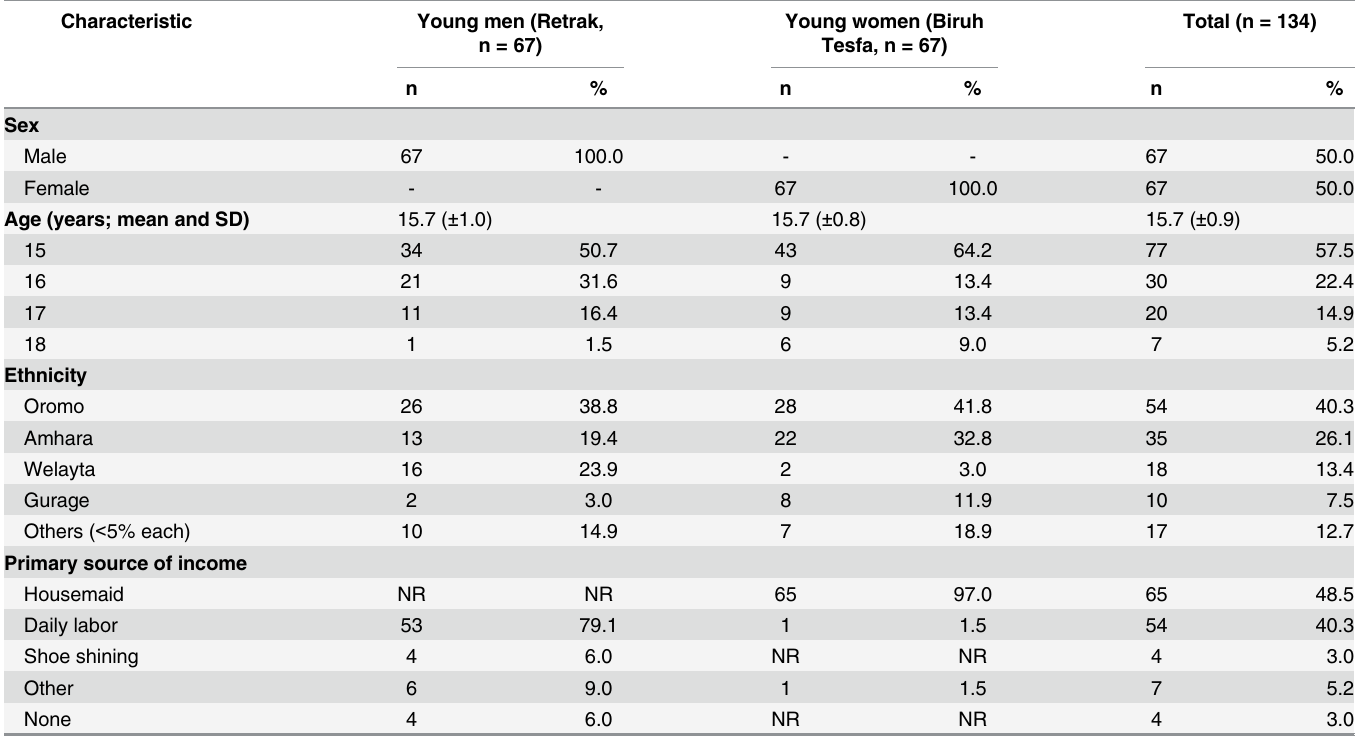
Table 1. Basic characteristics of participants assessed by the